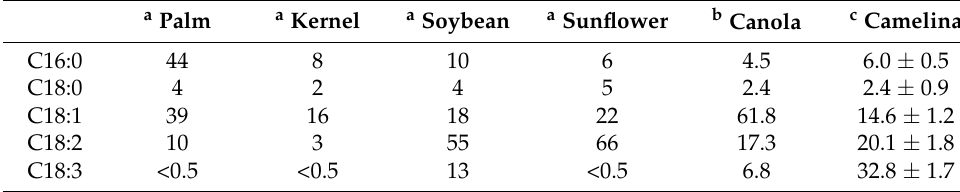
Table 3. Typical fatty acid composition in major oil crops and camelina (%). a Palm a Kernel a Soybean a Sunflower b